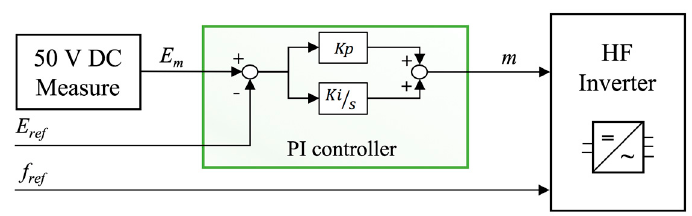
Figure 4. Control strategy for the converter “ HF Inverter ” regulating the 50_VDC voltage bus.